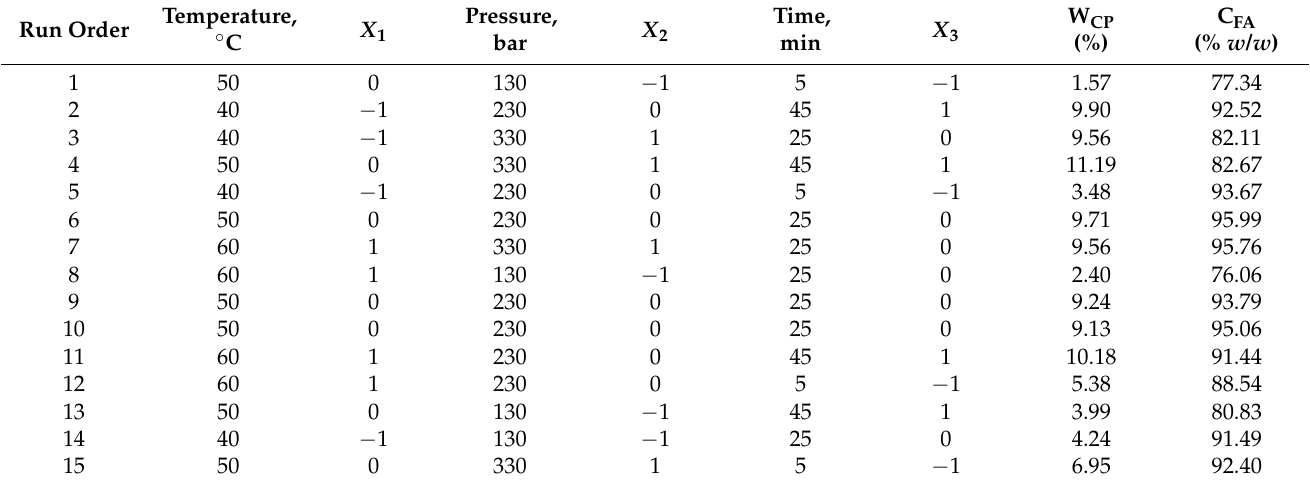
Table 1. Extraction parameters in individual experiments and the results of extraction of black-currant seeds with supercritical carbon dioxide on the ASFE MV-10 Waters